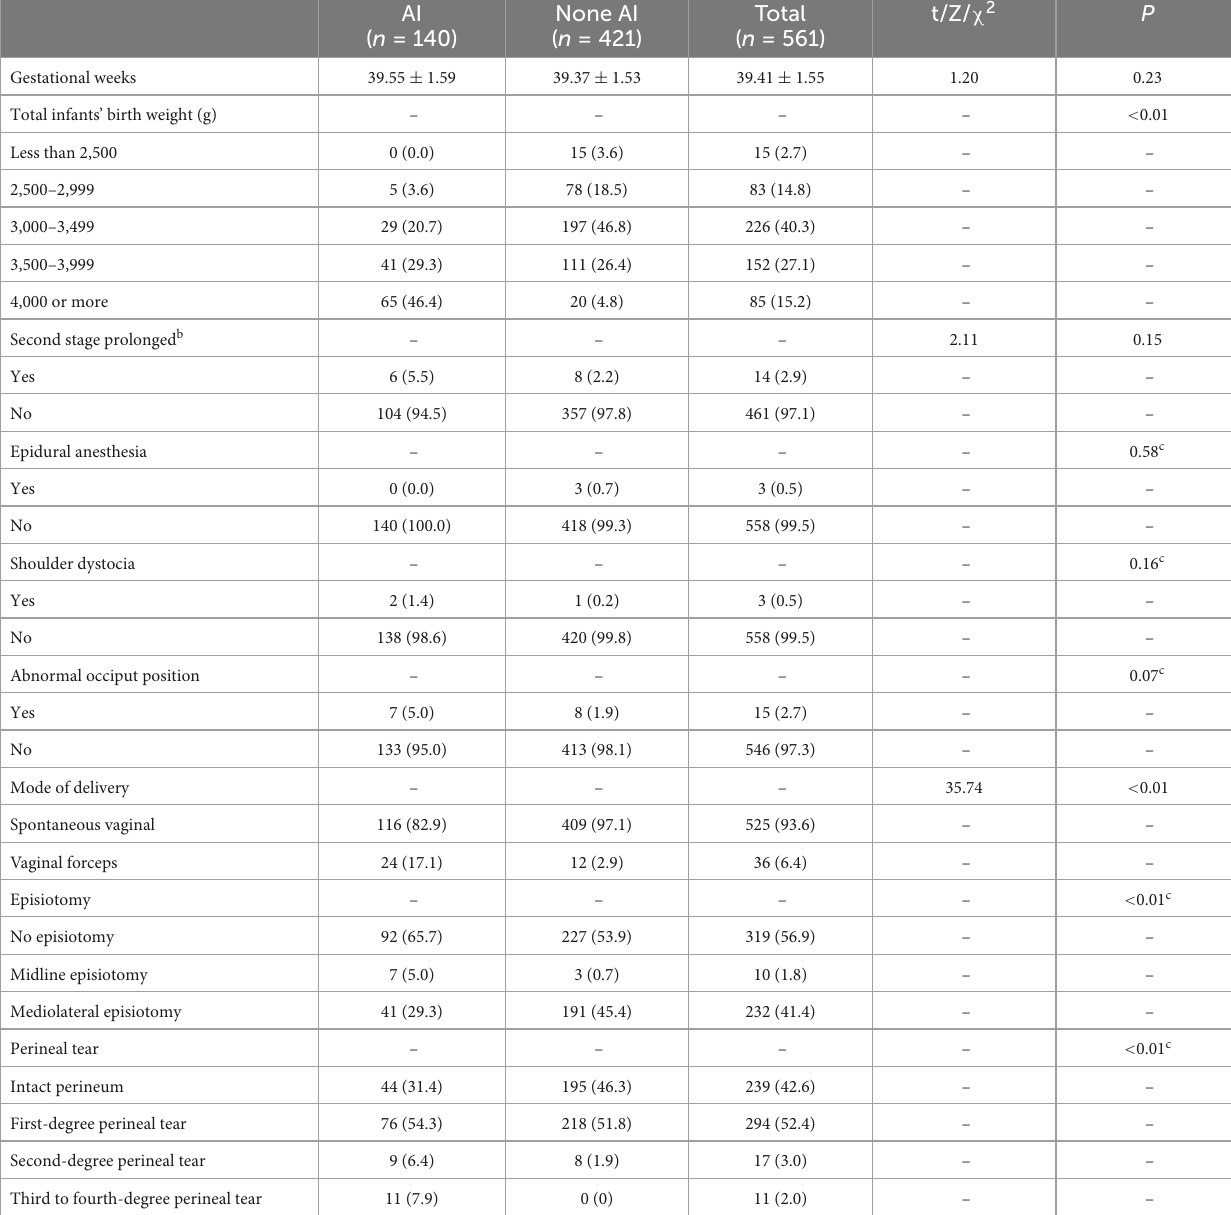
TABLE 3 Risk factors during labor associated with AI a